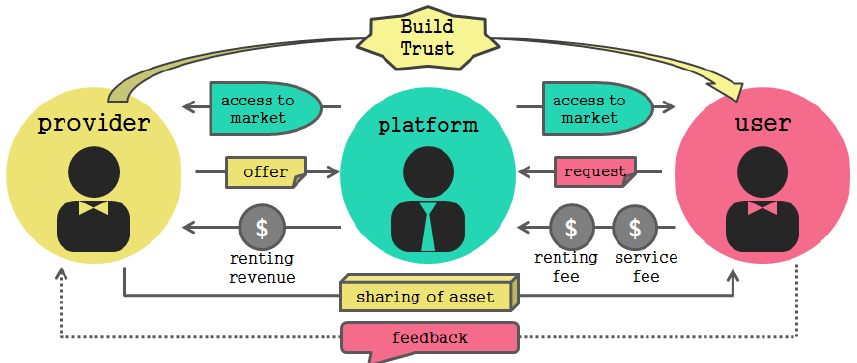
Figure 4. The structure of a sharing economy platform.